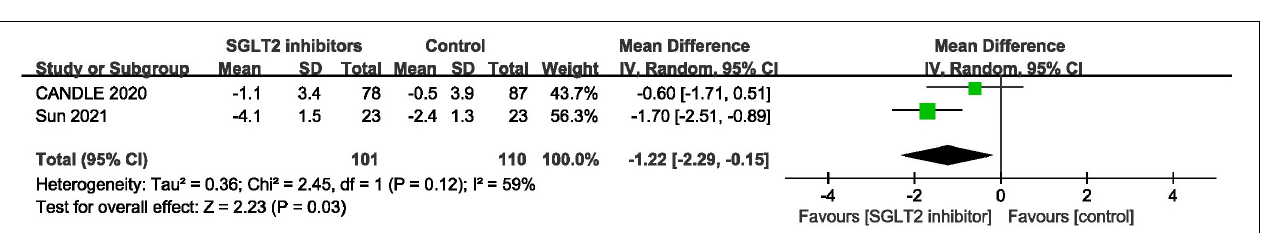
FIGURE 10 | Forest plot displaying the effects of SGLT2 inhibitors vs. placebo for E/e’ in HFpEF patients.